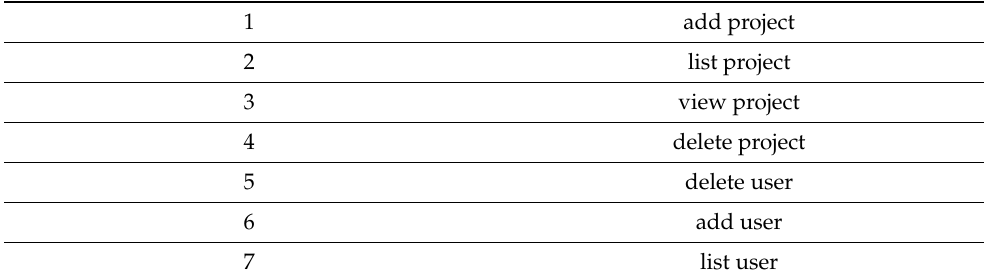
Table 2. Different types of tested